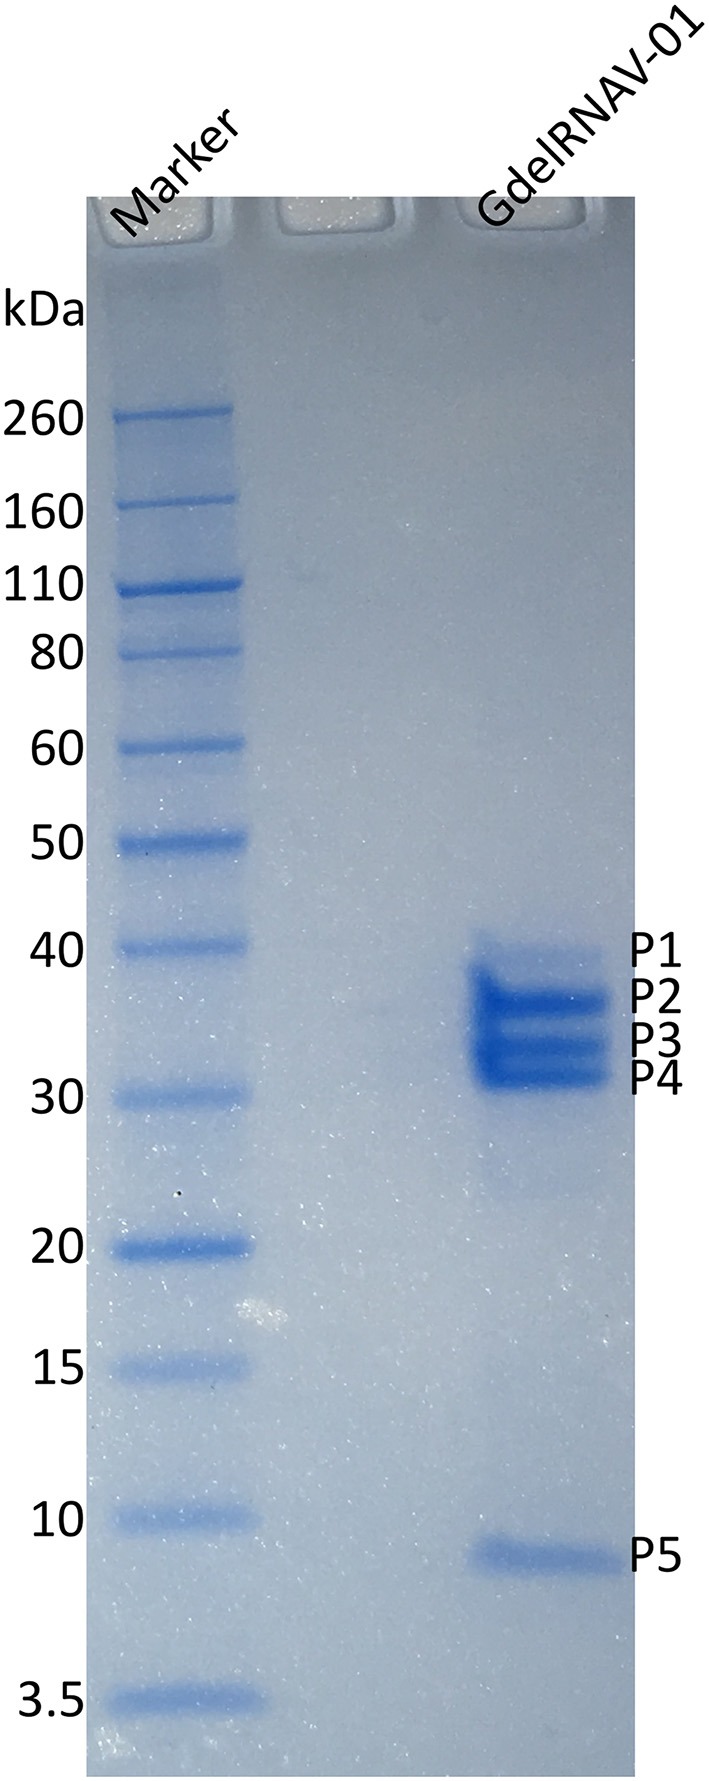
Analysis of the structural proteins of GdelRNAV-01 using SDS-PAGE. Lane Marker: Novex sharp unstained protein standard marker (kDa). Lane GdelRNAV-01: Denatured proteins of purified GdelRNAV-01. P1 to P5 represent the proteins 1 to 5.